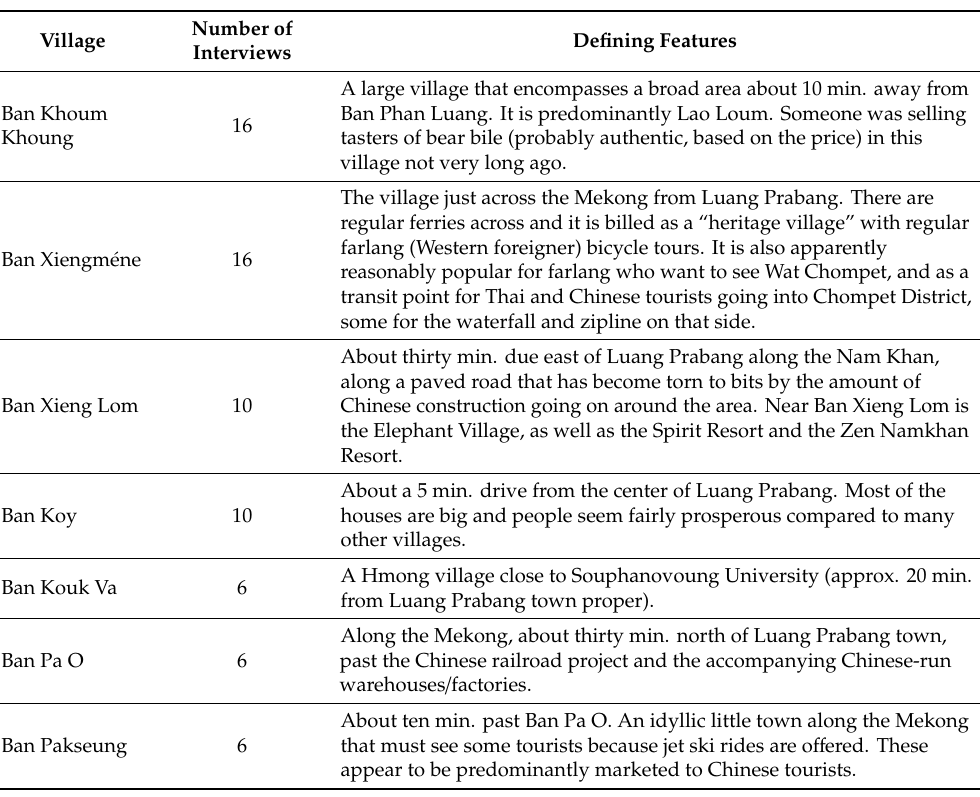
Figure 2. Map of the districts in Luang Prabang Province. Luang Prabang Town is in District 6-01 [39]. The villages exhibited a range of characteristics, from predominantly being Hmong, to lying adjacent to Chinese development projects, to being situated near one of many elephant sanctuaries in the area. The full table and list of characteristics of the villages is given in Table 1. Table 1. Villages where the interviews ( n = 100) were conducted.